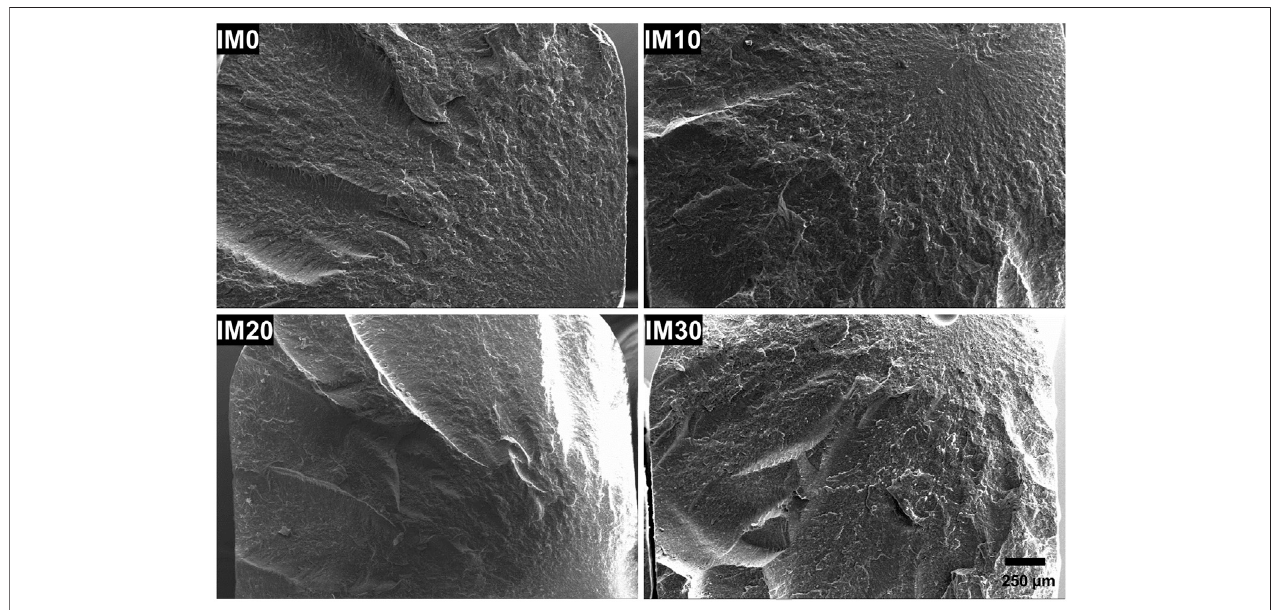
FIGURE 5 | SEM images of the fracture surfaces after tensile